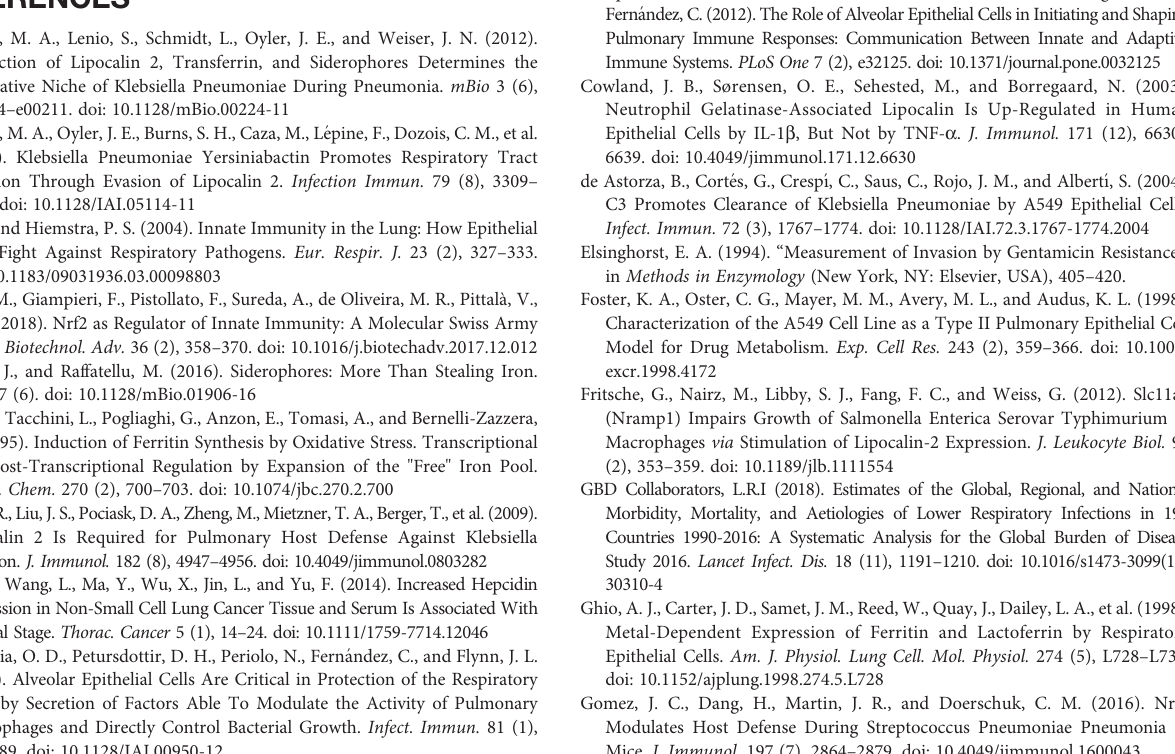
Supplementary Figure 3 | Growth assay of E. coli (A) or K. pneumoniae (B) . Bacteria in logarithmic growth phase were diluted to an OD 600 0.005 in cell culture medium or medium supplemented with 25µM iron (III) nitrate nonahydrate. OD 600 was continually measured over 600 minutes, means ± 95% CI (n=5) are shown. Supplementary Figure 4 | Densitometry of Western blots of key iron metabolism proteins FPN (A, B) , TFR1 (C, D) , FT (E, F) and NGAL (G, H) in infected A549 cells. A549 cells were infected for 2h with E. coli or K. pneumoniae at MOI of 10, subsequently washed thoroughly and harvested after 3h (left) or 6h (right) of intracellular infection. Data from three separate experiments are shown as mean ± SEM. * denotes p<0.05, ** denotes p<0.01, *** denotes p<0.001 for post-hoc statistical testing. K. pneu. , K. pneumoniae ; FPN, ferroportin; TFR1, transferrin- receptor-1; FT, ferritin; NGAL, neutrophil gelatinase-associated lipocalin 2.